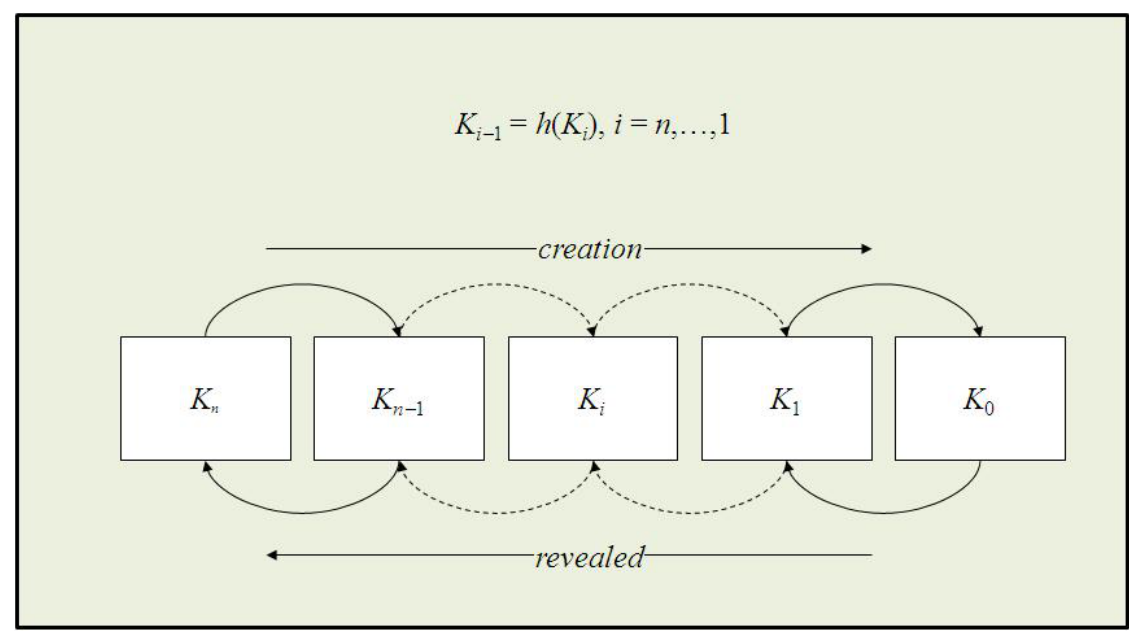
Figure 9. The hash chain.